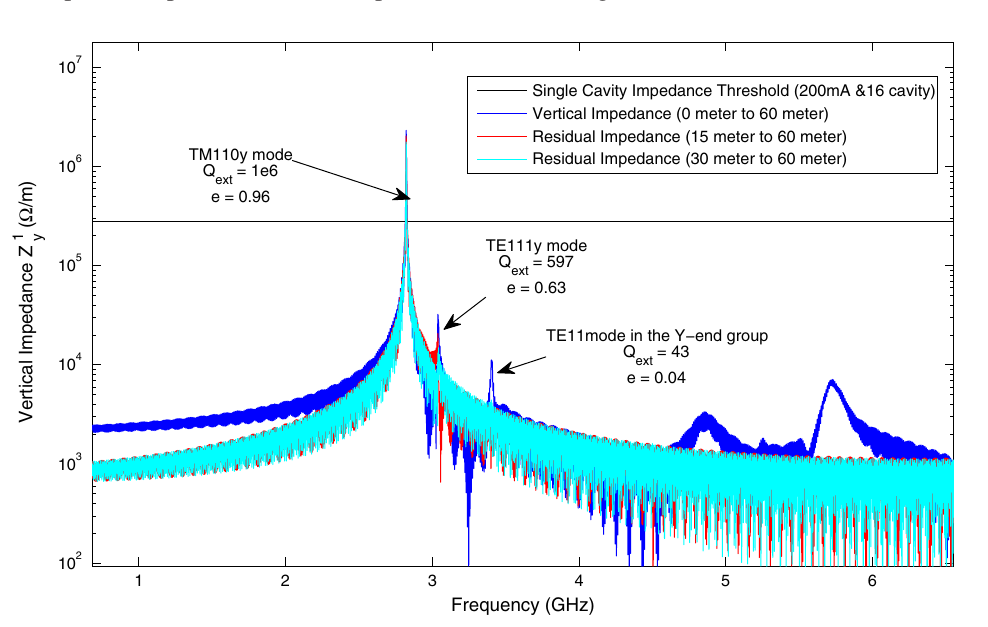
. Three impedance curves are compared: Z 60 m 0 y